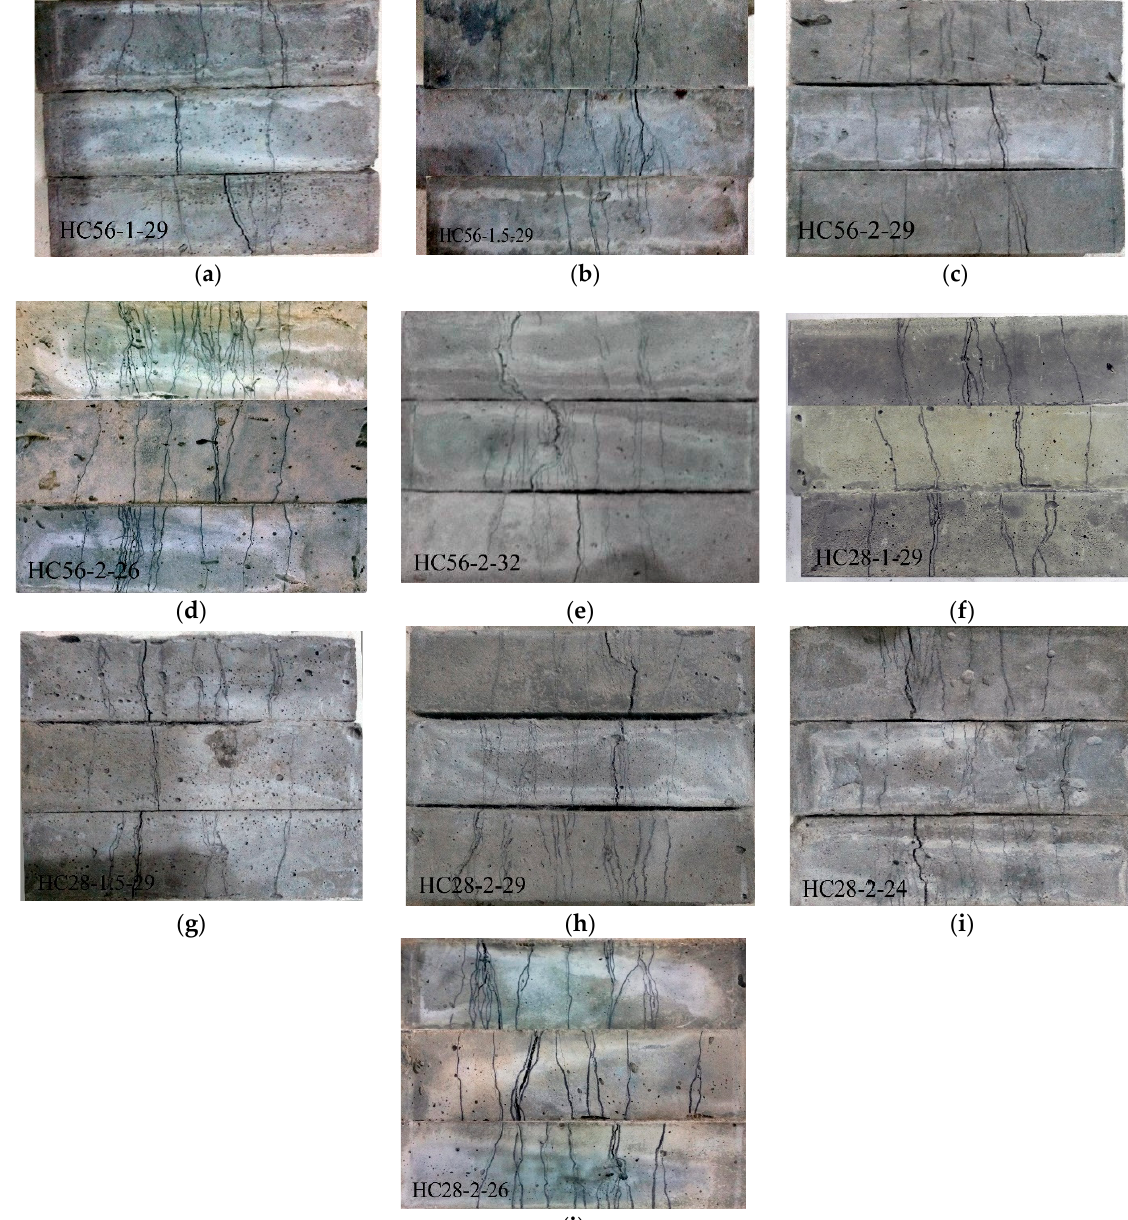
Figure 4. Failure pattern of the control specimens.